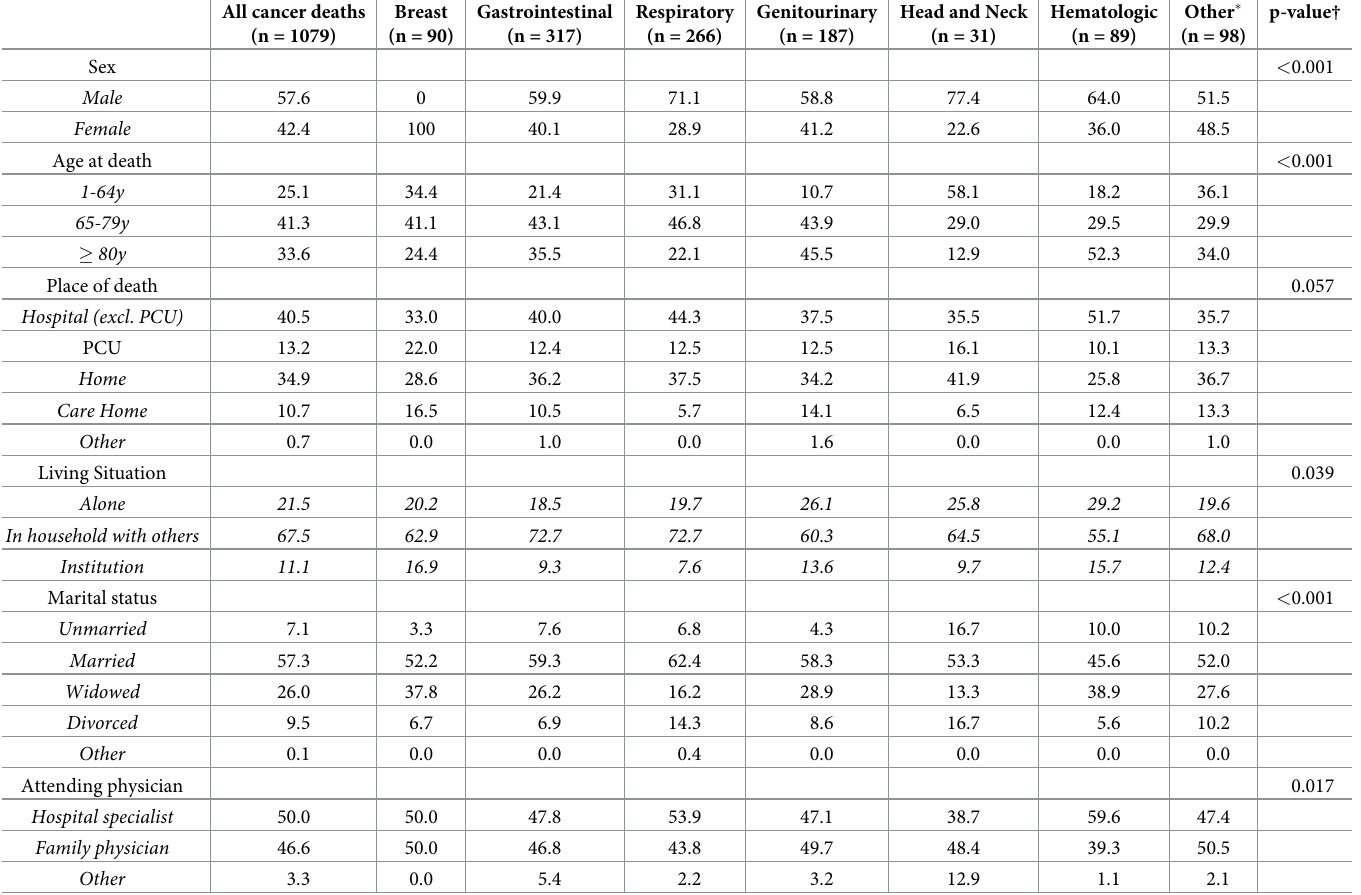
Table 1. Patient characteristics of all non-sudden cancer deaths according to cancer types (in percentages).